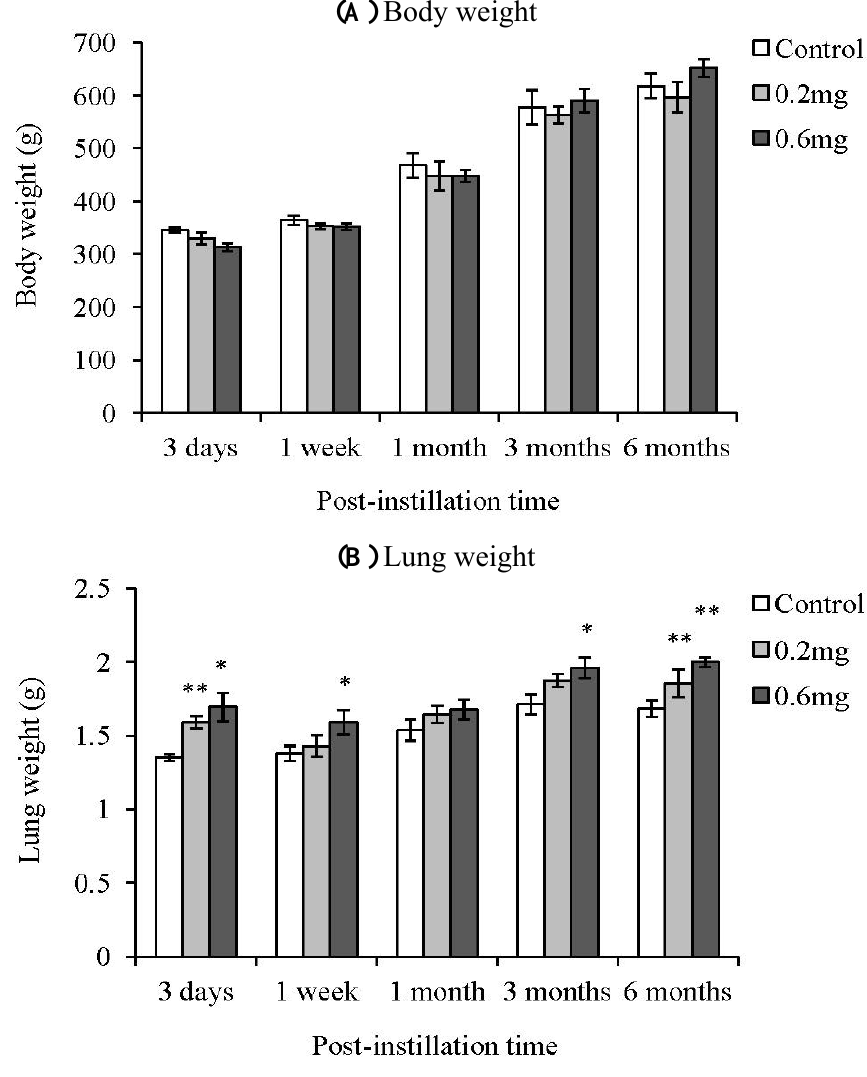
Figure 2. Body and lung weight of animals after intratracheal instillation of MWCNT. Values are mean ± SE ( n = 5). * p < 0.05, ** p < 0.01 ( vs. each negative control